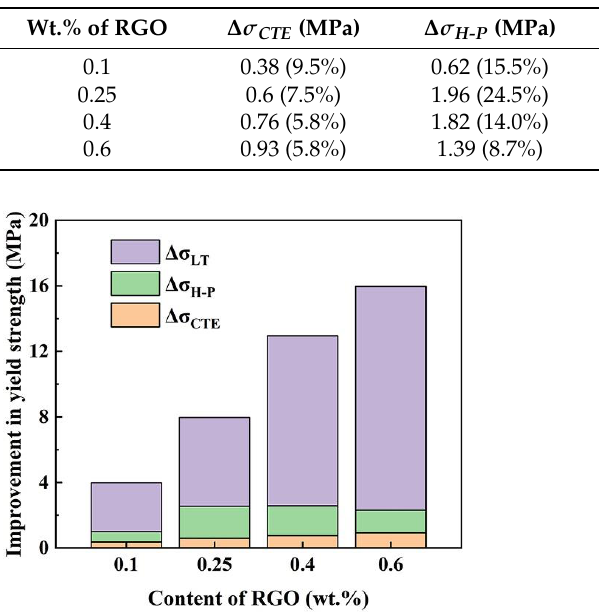
Figure 11. Contributions of each strengthening effect to RGO/ZK61 composites.